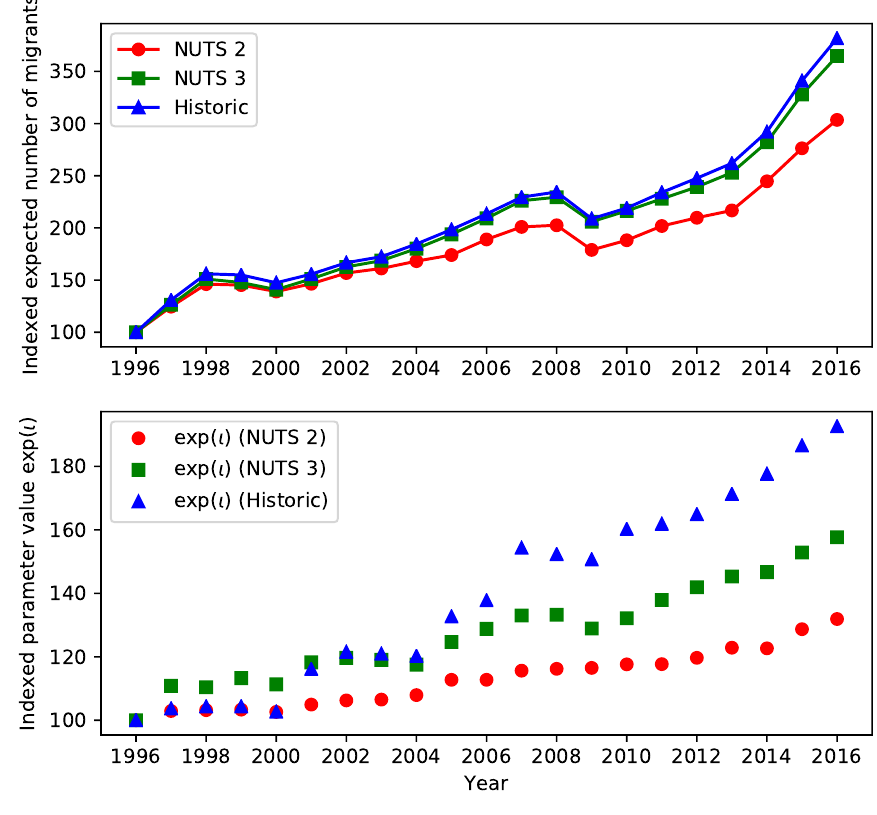
Figure 3. Indexed changes in the predicted number of migrants between two municipalities with 50,000 residents that are located 50 km apart and the indexed changes in the exp( ι ) value inside the model for each of the three sets of identity regions between 1996 and 2016. For every year, all municipalities were merged to form the municipalities that existed in 2016 to prevent the different numbers of municipalities from having any